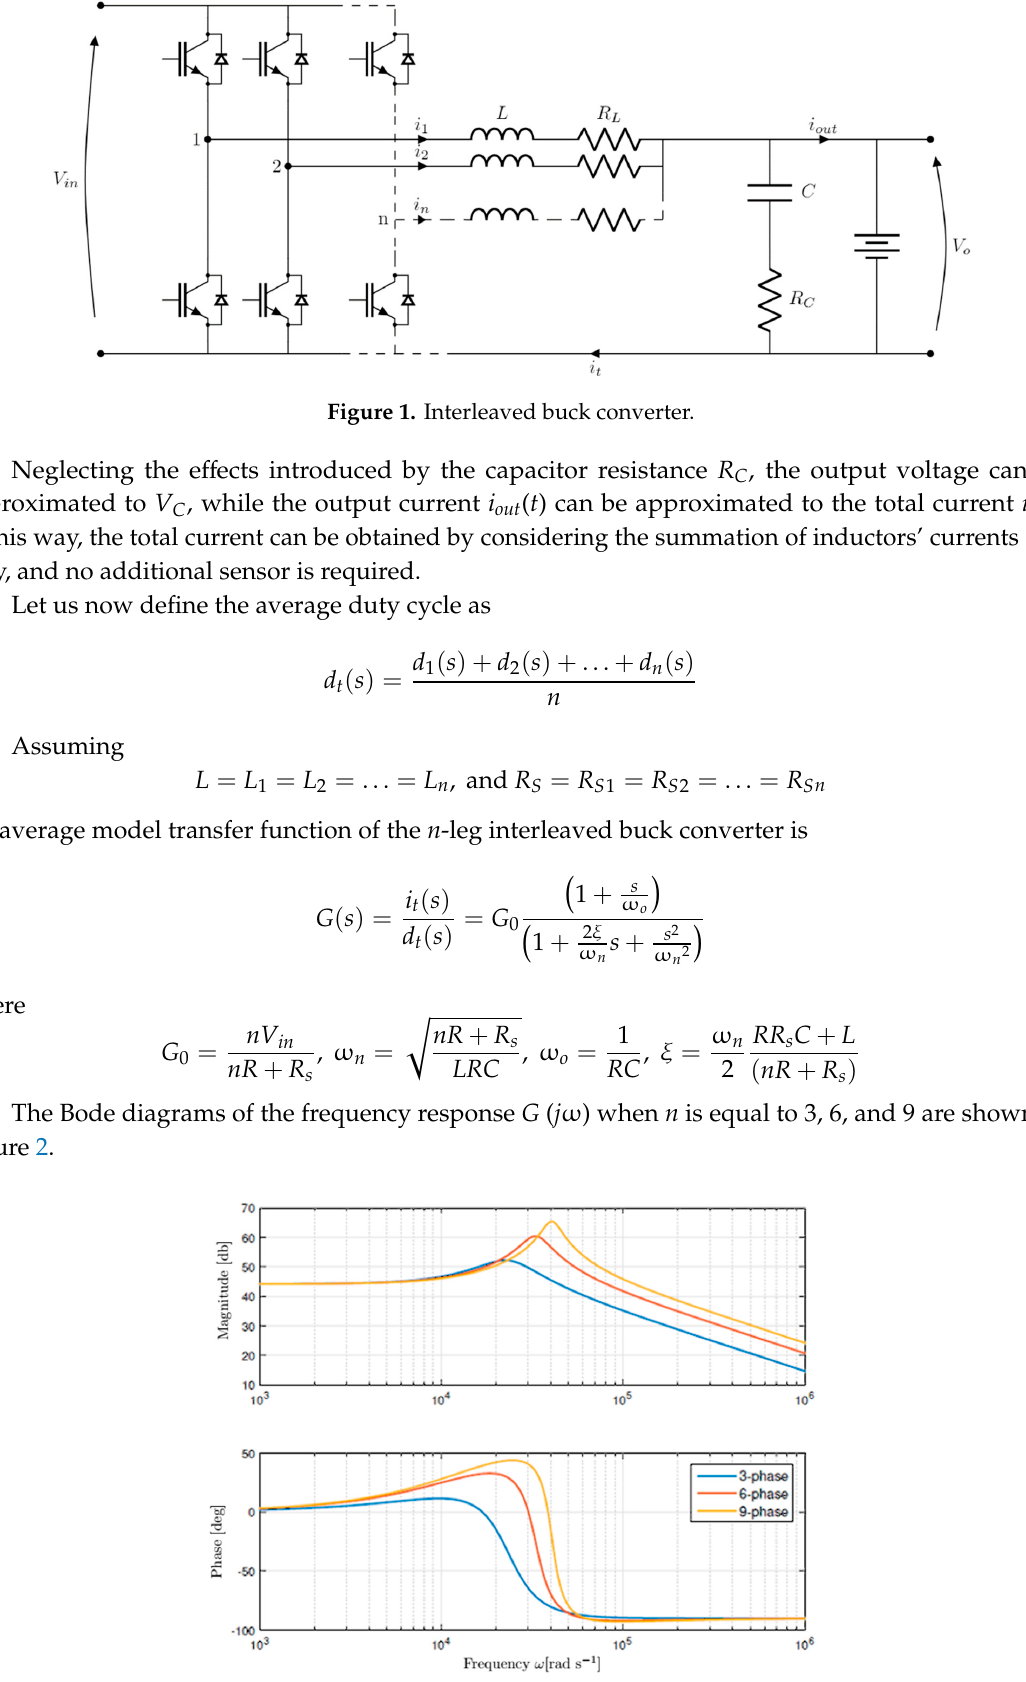
Figure 2. Bode diagrams of the frequency response G ( j ω ) of an interleaved buck converter.